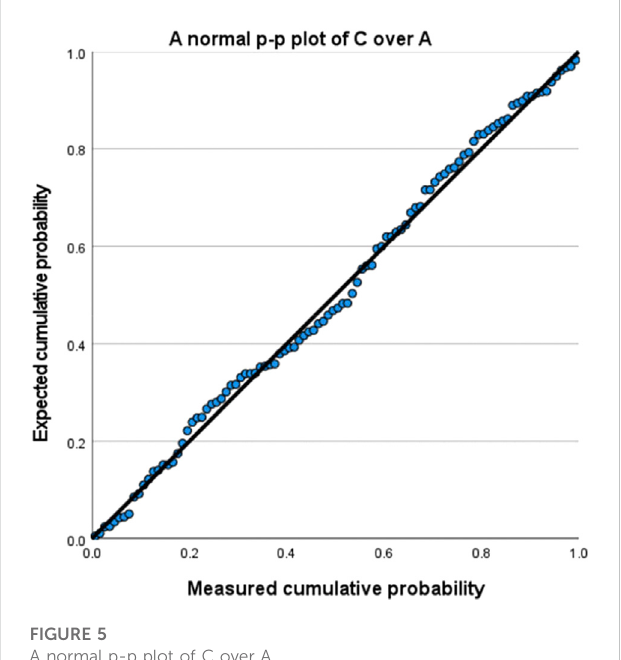
FIGURE 4 A normal p-p plot of B over A.